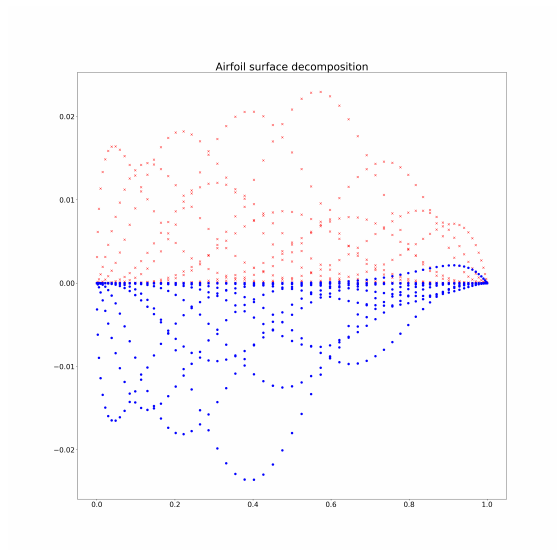
Figure 4. The decomposition in terms of Bernstein polynomials of airfoil RAE2822’s shape.